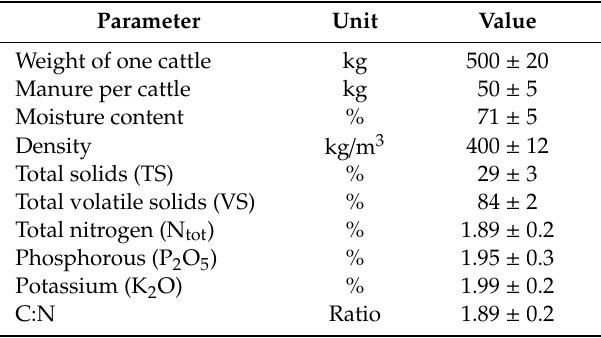
Table 1. Characteristics of the raw compost material.